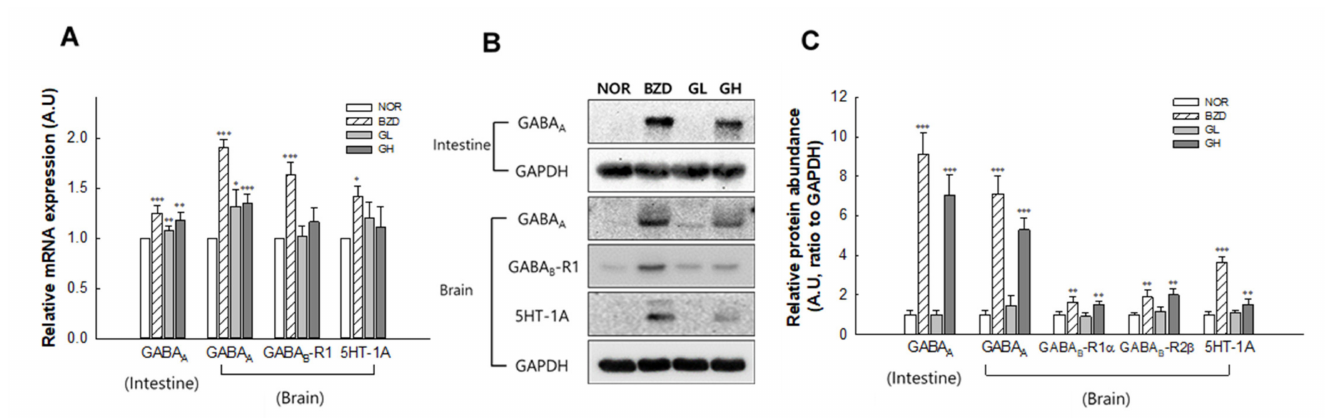
Figure 7. Effect of Lactobacillus -fermented γ -aminobutyric acid (LB-GABA) on mRNA and protein expressions of GABAergic and serotonergic receptors in mice. Target mRNAs and proteins from mice were analyzed via quantitative real-time PCR and Western blot, respectively. ( A ) mRNA expression of GABA A (intestine), GABA A (brain), GABA B -R1 and 5HT-1A receptors. ( B ) Protein abundances and ( C ) relative quantification of GABA A (intestine), GABA A (brain), GABA B -R1 α / β , and 5HT-1A receptors. NOR: normal control (0.9% sodium chloride [NaCl]) group, BZD: benzodiazepine (alprazolam, 200 µ g/kg)-treated group (positive control), GL and GH: low- and high-dose LB-GABA (60 and 100 mg/kg), respectively. Values are the means ± standard deviation (SD); * p < 0.05, ** p < 0.01, and *** p < 0.001 versus normal control group according to Tukey’s multiple comparison test. A.U: arbitrary